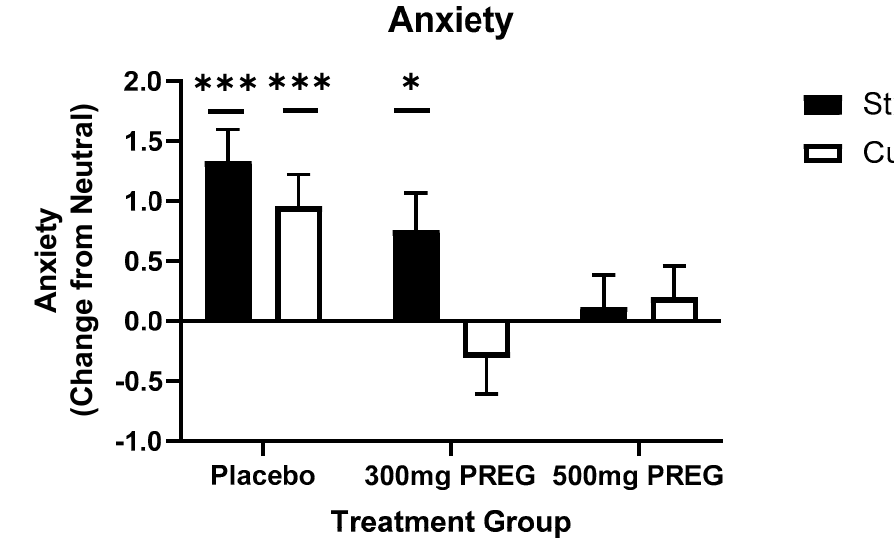
Figure 4. Anxiety as a function of imagery condition and placebo vs. PREG treatment groups. Stress-induced anxiety was significantly higher in the 300 mg PREG group compared to neutral ( p = 0.016), and in the placebo group in response to stress ( p < 0.001) and cocaine cue ( p < 0.001) compared to neutral, but not in the 500 mg PREG group ( p = n.s.). All data are displayed as mean ± S.E.M. * Significance represents condition relative to neutral. * p < 0.05; *** p < 0.001.